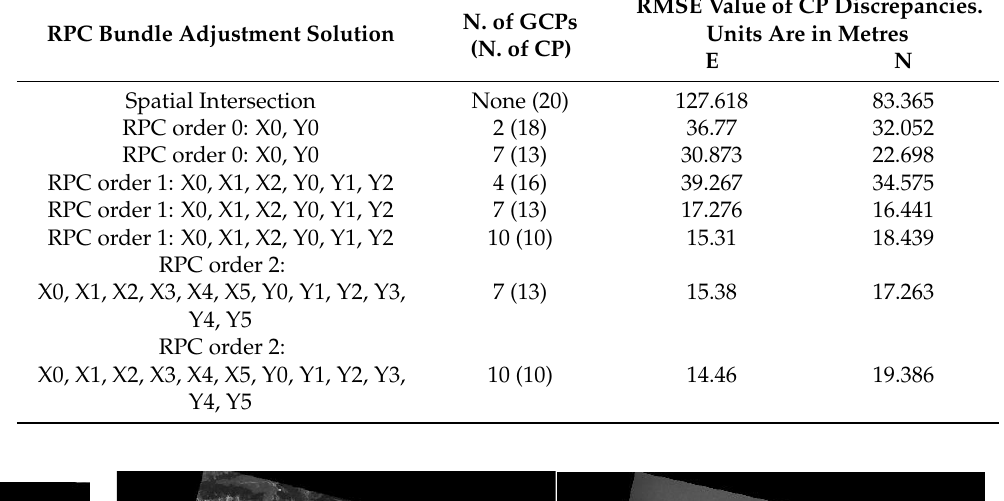
RPC Bundle Adjustment Solution